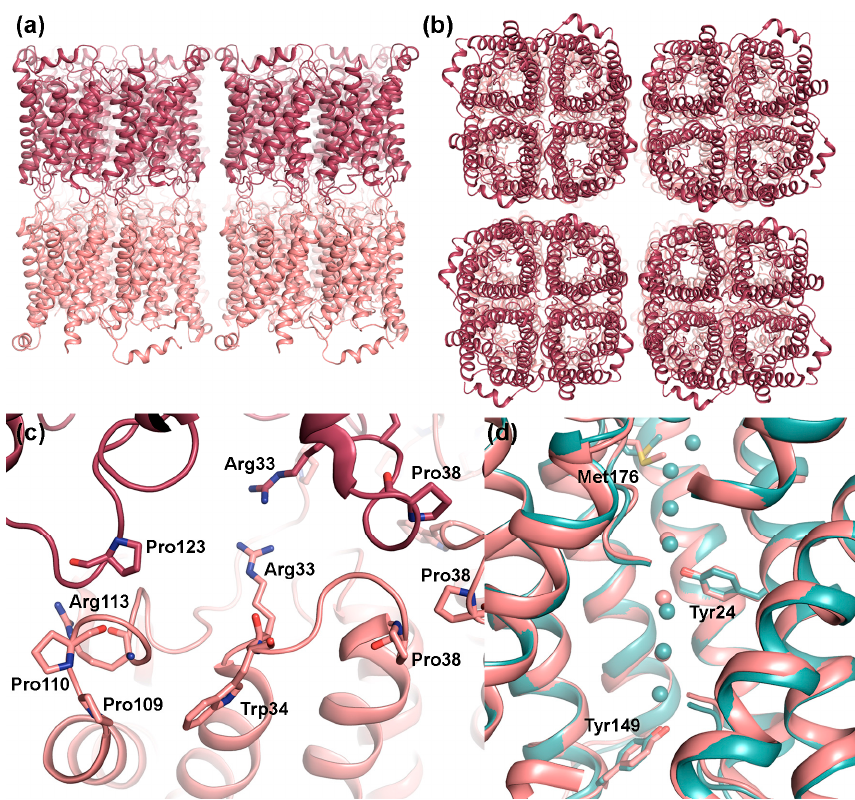
Figure 3. Structural features of AQP0 in junctions. Doubled layered 2D crystals of sheep AQP0 (PDB code 2B6O) viewed: ( a ) parallel and ( b ) perpendicular to the membrane plane. The tetramers in the two adjacent membranes are perfectly in register. ( c ) Close-up of residues involved in the interaction between tetramers. Within loop C, Pro109 and Pro110 interact with same motif in the opposite layer (not shown in figure) while Pro123 interacts with Arg113. Interactions also involve Arg33 and Pro38 in loop A. In non-junctional AQP0, the side-chains of Arg33 and Trp34 swap positions, blocking the interaction with the opposite tetramer, and Pro38 moves away from the tetramer centre. ( d ) Structural comparison of junctional (pink) and non-junctional (turquoise, PDB code 1YMG) AQP0 showing how the side-chains of Met176, Tyr24 and Tyr149 constrict the water pore. Pore closure upon junction formation is believed to be mediated by the difference in side-chain conformation of